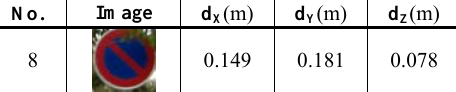
Table 1. Examples of recognized traffic